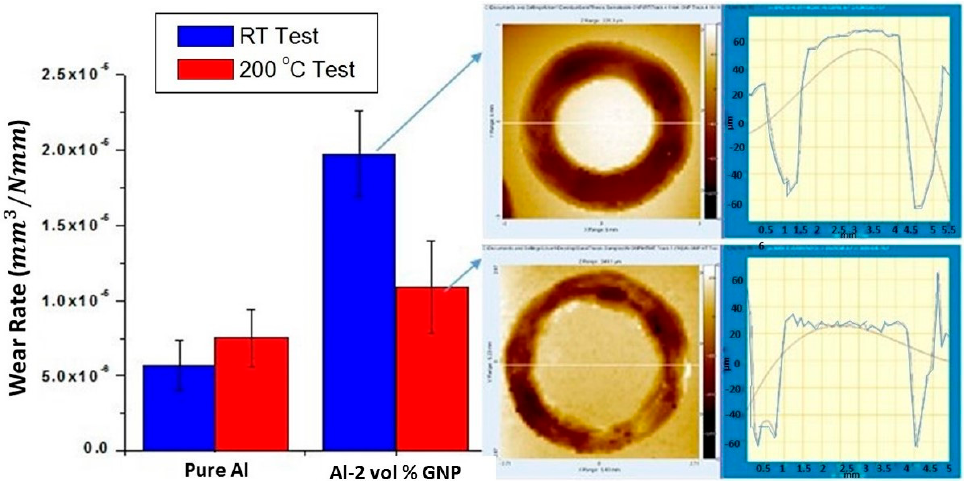
Figure 5. Wear rate at room temperature and 200 °C for all samples.